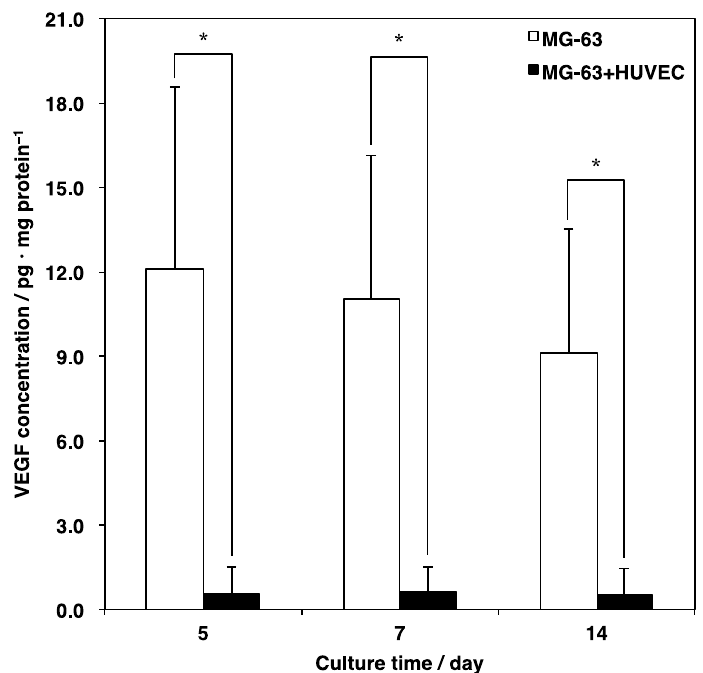
Figure 8. Comparison of vascular endothelial growth factor (VEGF) secretion in a monoculture and a co-culture on a microfiber scaffold. Cells were seeded at 5.0 × 10 5 cells cm –3 on the scaffold placed in each well of a 24-well plate and cultured for five, seven, and 14 days. VEGF production was assessed using a sandwich ELISA described in Materials and Methods. Data were determined from three replicate samples, which are shown as mean ± SD. * p < 0.05 compared with monoculture (MG-63 cells alone).